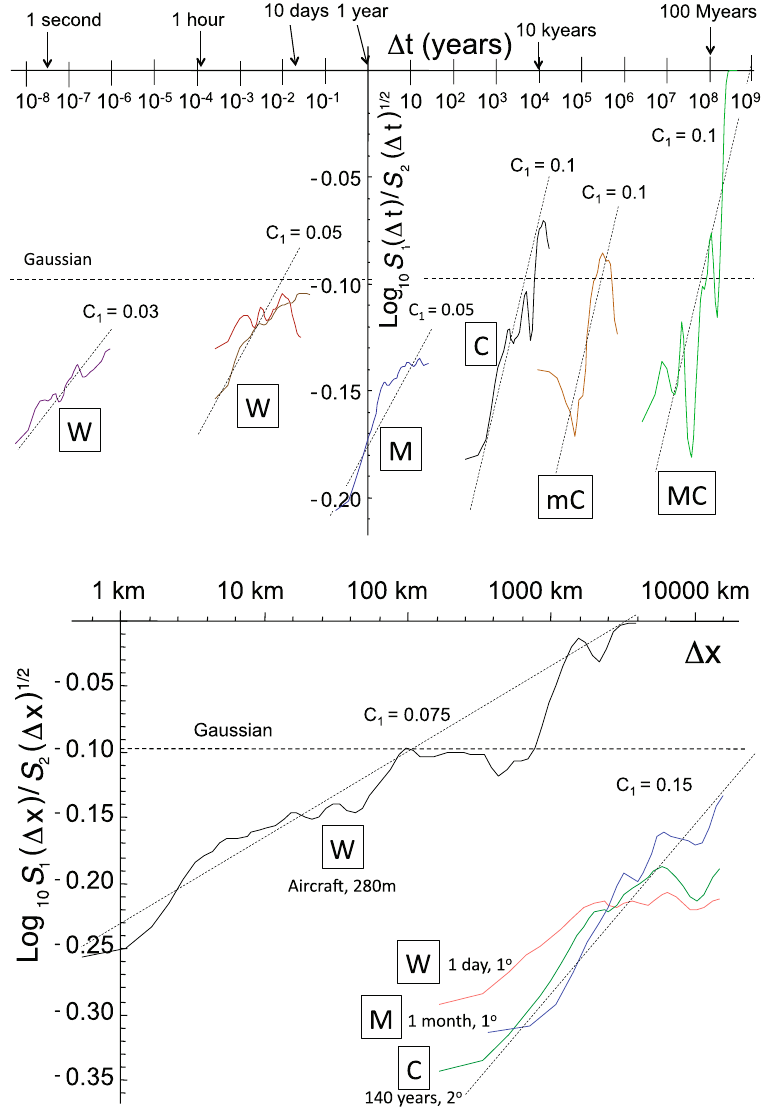
Figure 4. (a) (top panel): The ratios of the first moments ( S 1 ( Δ t )) to RMS moments ( S 2 ( Δ t ) 1/2 ) for the same data used in Fig. 2b. The slopes give the exponent aC 1 (see the text). Using estimates of a = 0.86 (see Methods), reference lines with various intermittency exponents C 1 are shown. Gaussian processes are independent of scale Δ t , they would lie along the dashed line. Since each curve is from ratios of statistics taken from data at different resolutions, we do not expect that the separate curves will be part of a single overall curve as they were in Fig. 1. (b) (bottom panel): The same as ( a ) but for the transects used in Fig.